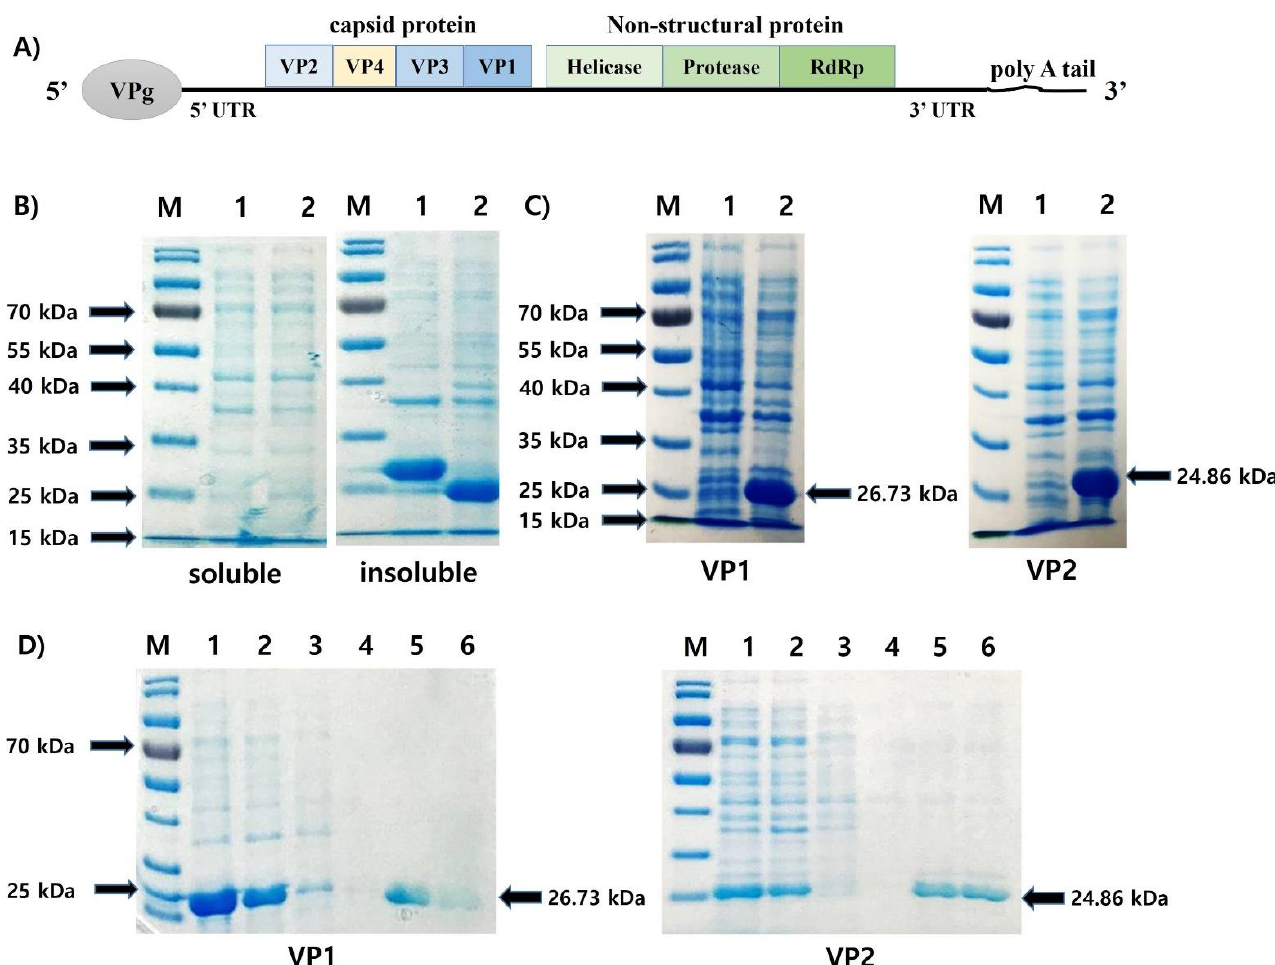
Figure 1. ( A ) Genome organization of AcSBV. ( B ) IPTG (final concentration at 1 mM) induction for the expression of pET-28a vector containing AcSBV-VP1 (lane 1) and AcSBV-VP2 (lane 2). Soluble fraction (left) and insoluble fraction (right) of the Escherichia coli BL21(DE3) transformants. ( C ) Insoluble fraction of wild-type (lane 1) and transformant (lane 2) E. coli BL21(DE3). ( D ) Purification of the recombinant VP1 (rVP1) and VP2 (rVP2) proteins by Ni-NTA resin chromatography under denaturing conditions. M: protein molecular weight marker; lanes 1–2: cell lysate 1 and 2; lanes 3–4: first washing and second washing; and lanes 5–6: first elution and second elution. Arrows indicate rVP1 (26.73 kDa) or rVP2 (24.86 kDa).